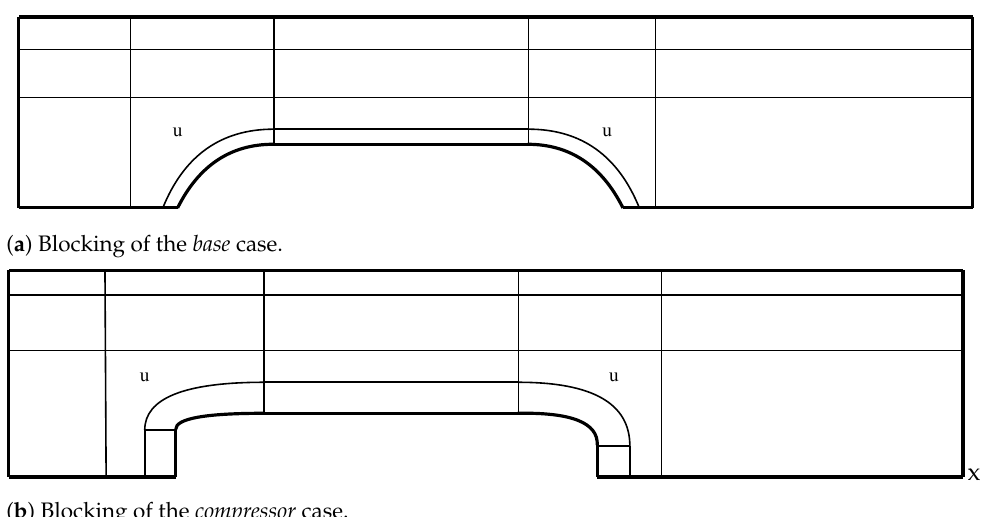
Figure 3. Blocking chosen for the mesh. Reference for the base case